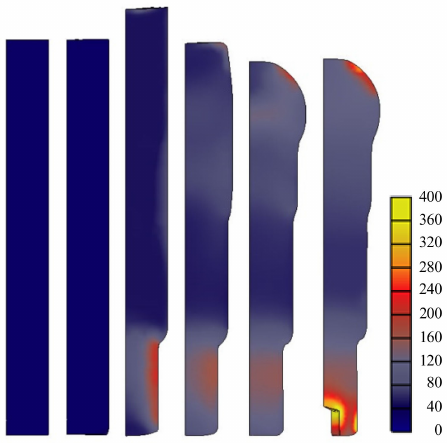
Figure 9. The predicted metal flow lines and e ff ective strains: ( a ) metal flow lines; ( b ) e ff ective strains.